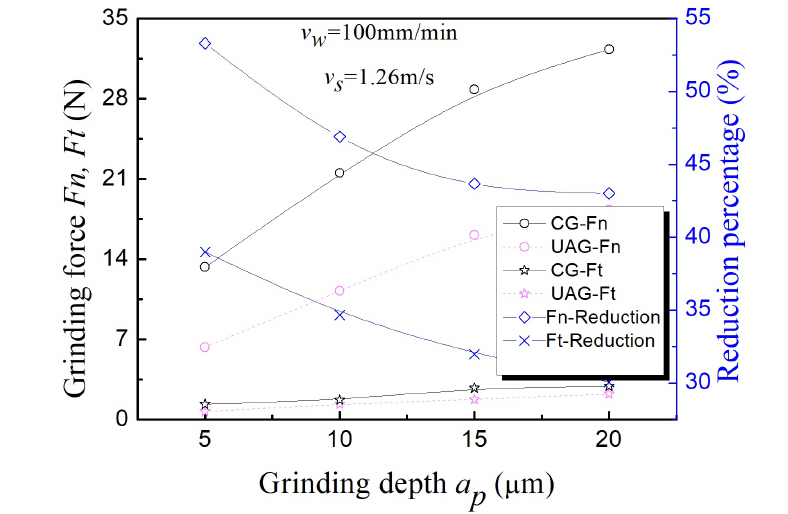
Figure 10. End grinding: the influence of grinding depth changes on the grinding